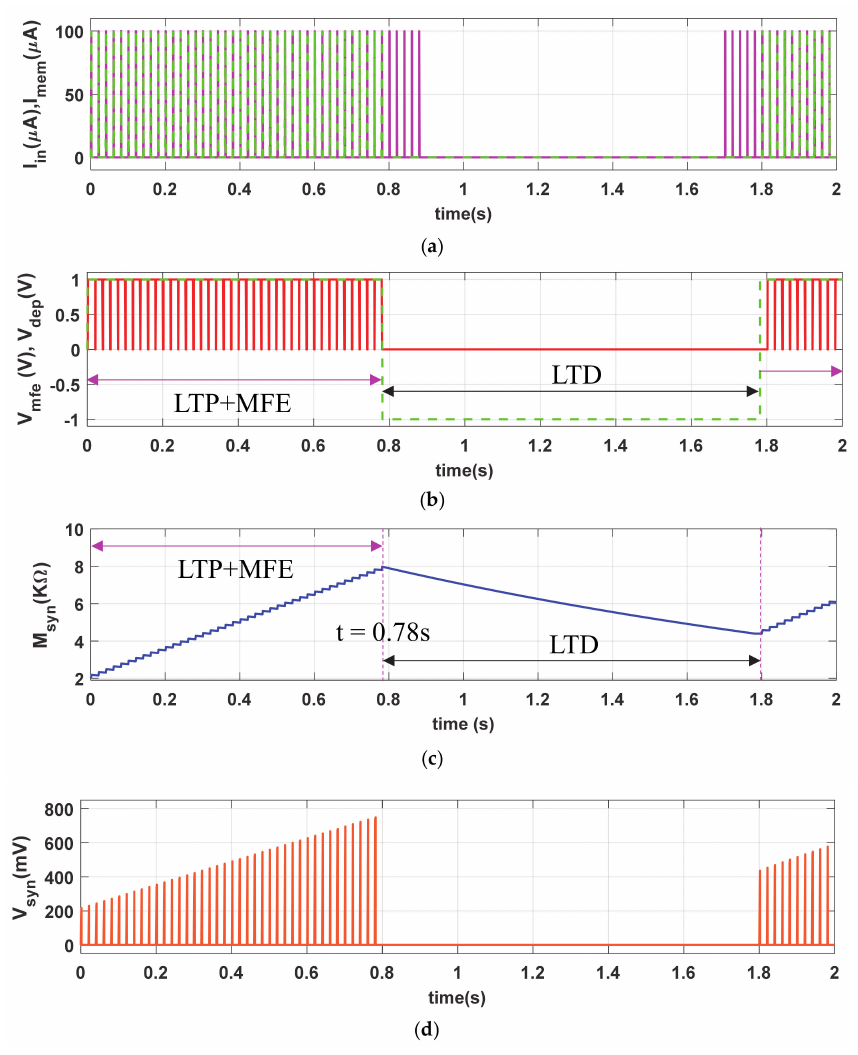
Figure 4. Long-term potentiation (LTP) and long-term depression (LTD) synaptic response of neuro- memristive synapse: ( a ) input stimulus (I in ) and current stimulus passes through proposed synapse (I mem ), ( b ) control signals of V mfe and V DEP , artificial synaptic ( c ) strength (M syn ), and ( d ) voltage (V syn